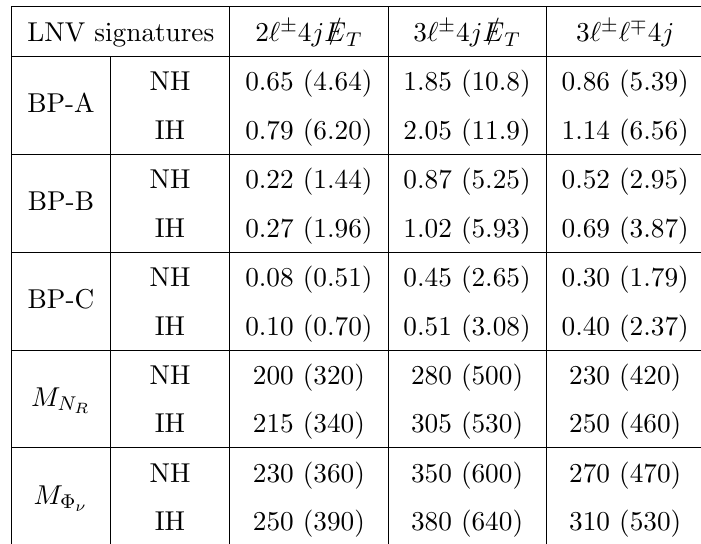
Table 7 . Summary of statistical signi(cid:12)cance for three types of signatures at three benchmark points and of approximate lower bounds on new particle masses to be expected at LHC13@100 (LHC14@3000) for neutrino masses in either NH or IH. . 300 GeV and m . 350 GeV will be excluded by LHC13@100, and the excluded m N R (cid:8) (cid:23) . 500 GeV and m . 600 GeV by the region will be extended at LHC14@3000 to m N R (cid:8) (cid:23) SST